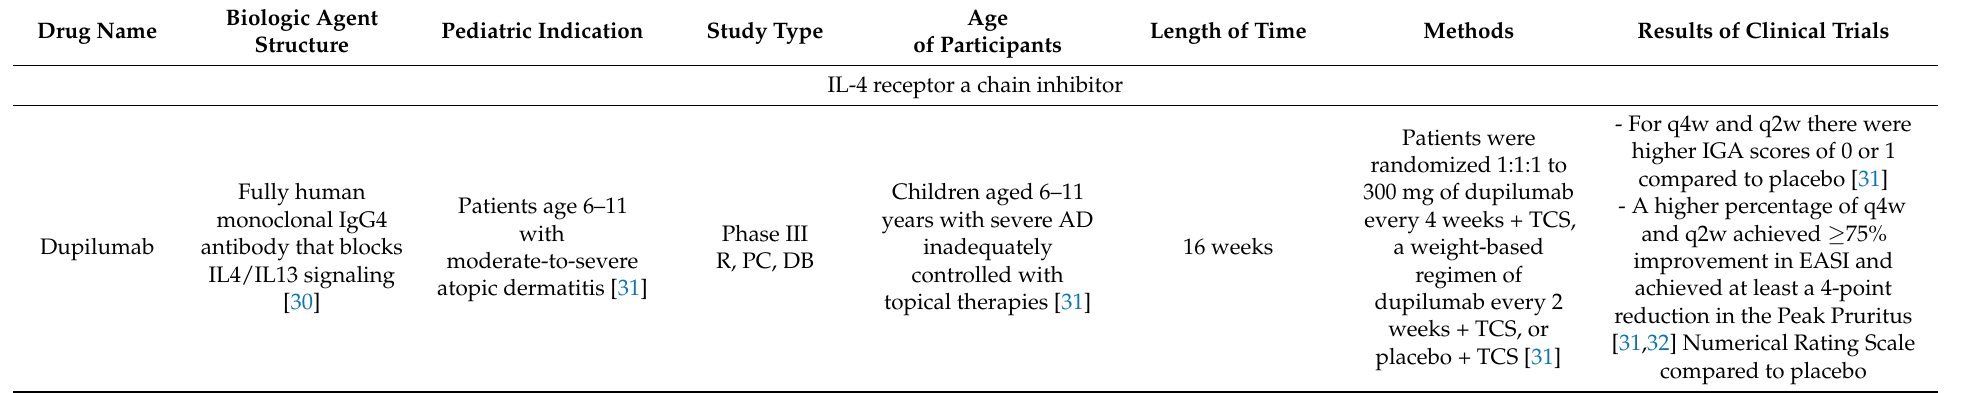
Table 1. Biologics indicated for the treatment of atopic dermatitis in children.